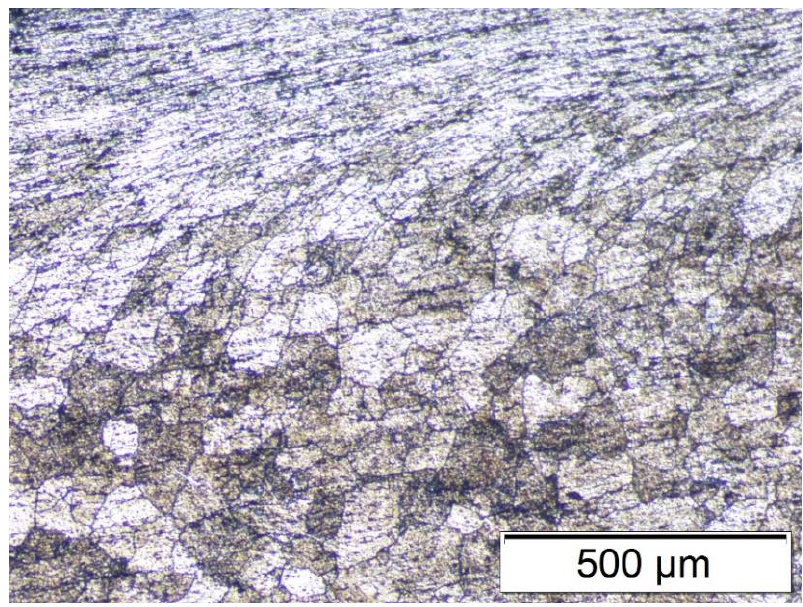
Figure 10. OM micrograph of AA2011 after processing through 2-Bc at the